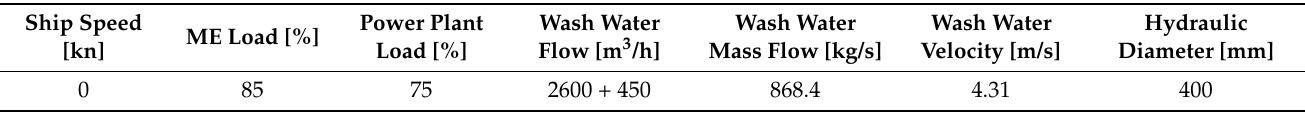
Table 4. Load case